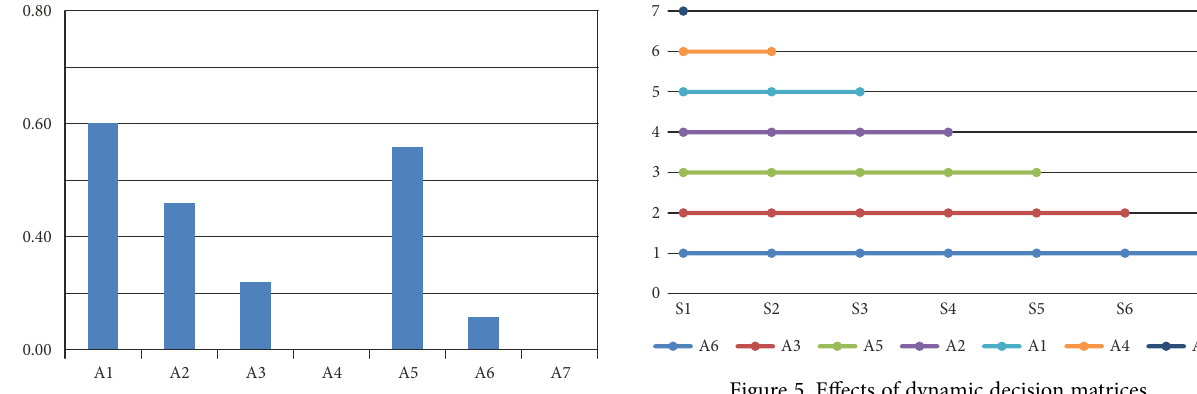
Figure 5. Effects of dynamic decision matrices in LNN–OS–MABAC method